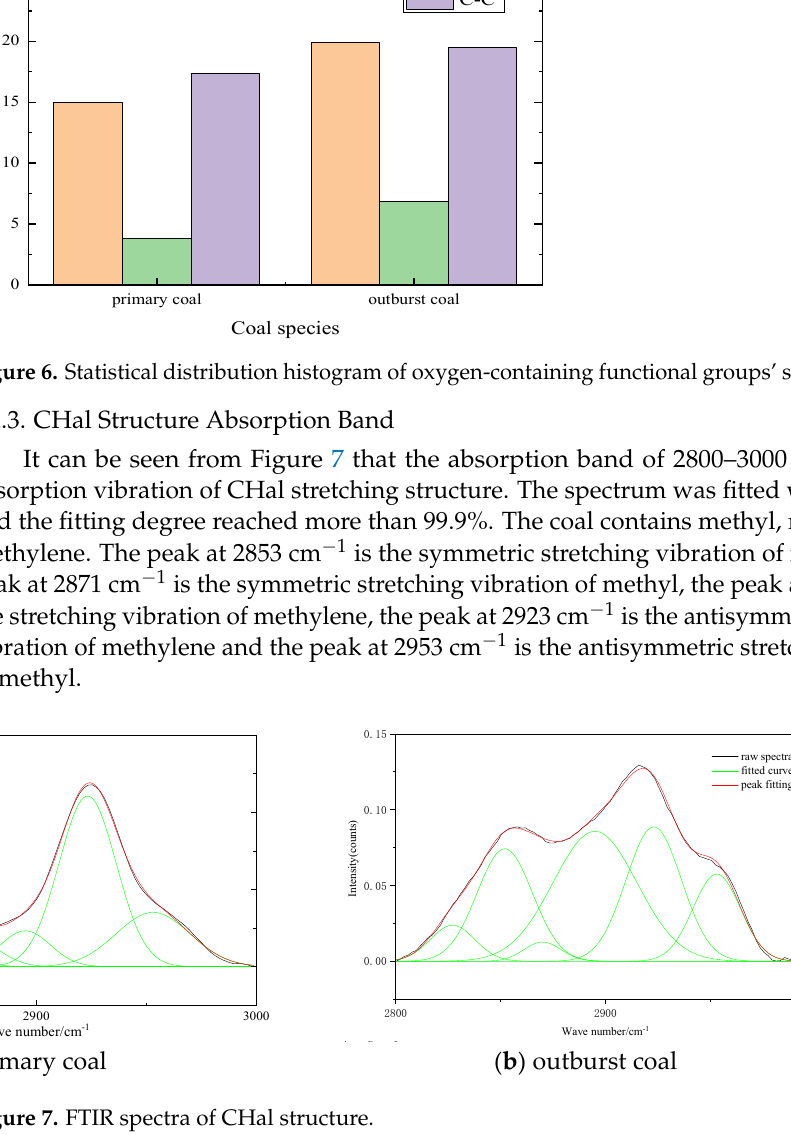
Figure 7. FTIR spectra of CHal structure.